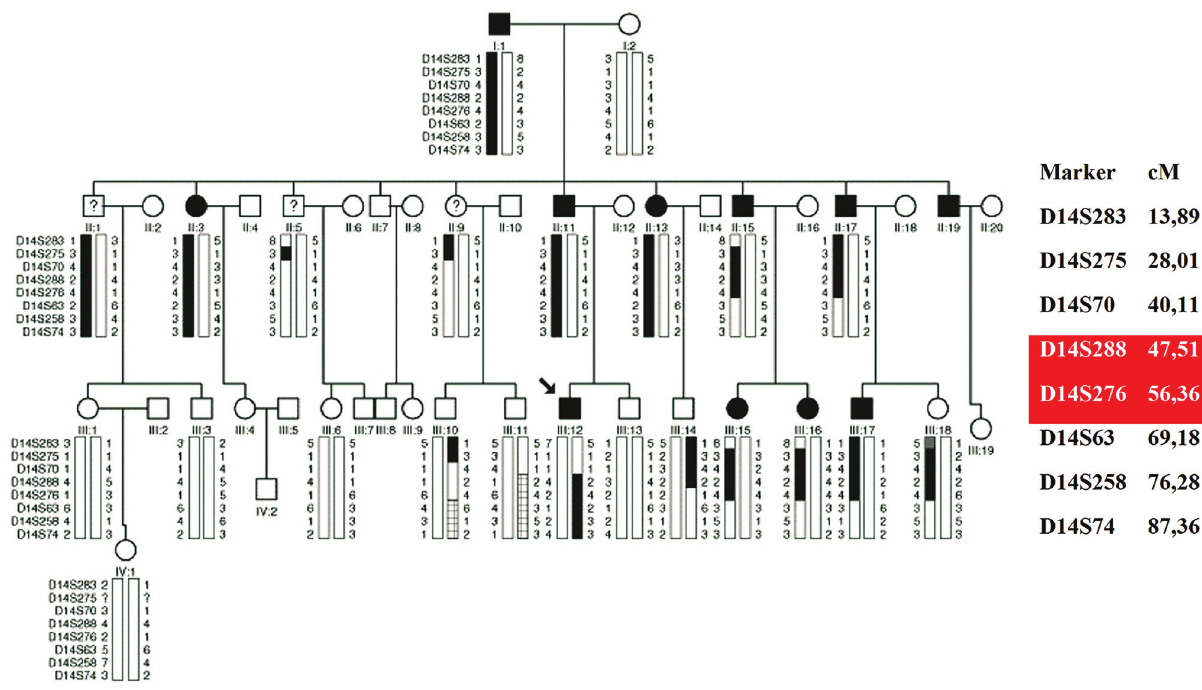
Figure 1 - Pedigree and haplotype segregation of microsatellites in chromosome 14. Individuals with DNA samples collected are marked with the sym- bol (-). The proband is indicated by an arrow. Individuals with ? are affected by hearing loss only in high frequencies, with age of onset at 40 years. The mapped locus based on haplotype segregation is represented in red. Partially striped chromosomes probably resulted from a crossing over